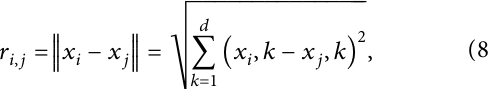
Algorithm 1: Hybridization of the support vector